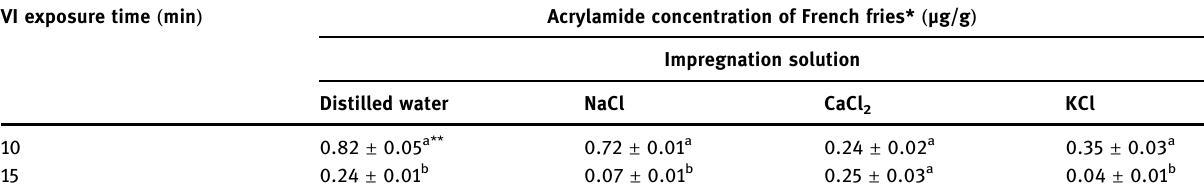
Table 2: Changes in acrylamide contents of French fries produced from raw potato strips pre - treated by VI in four di ff erent solutions for di ff erent times VI exposure time ( min